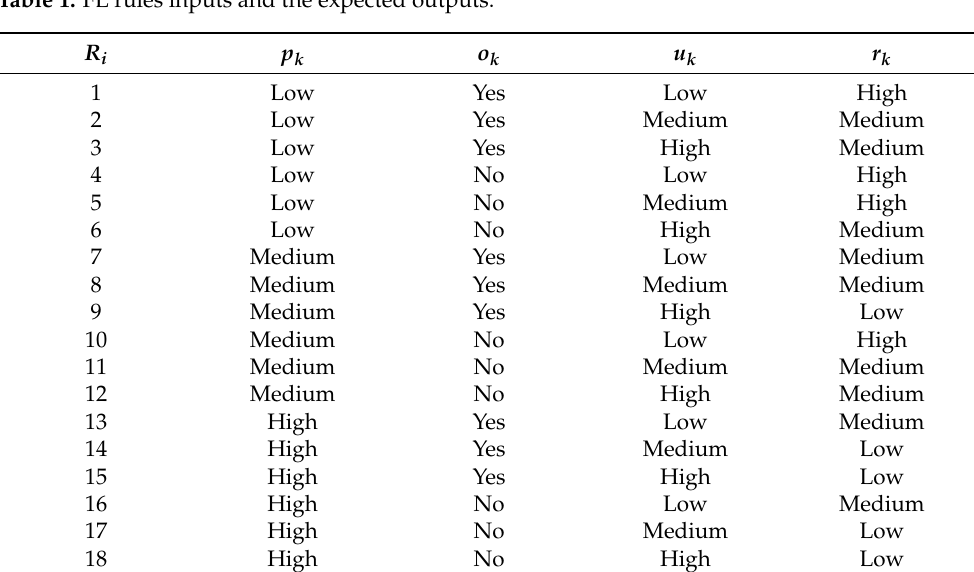
Figure 3. Fuzzy logic system working mechanism. Table 1. FL rules inputs and the expected